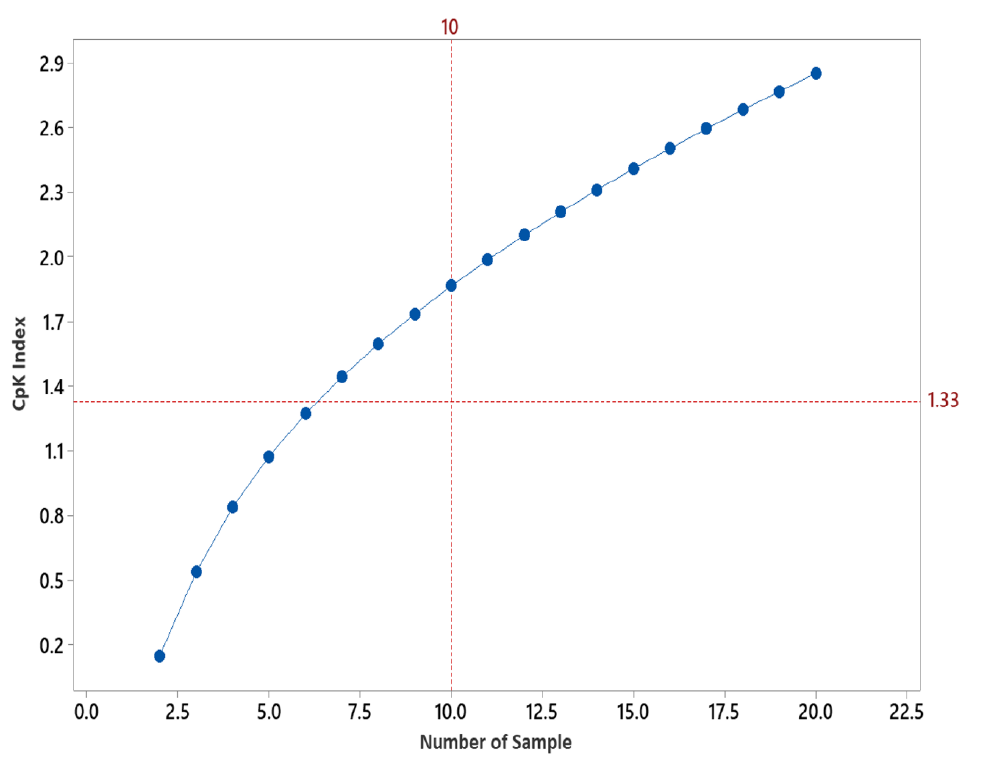
Figure 2. The graph shows the CPK index against the sample